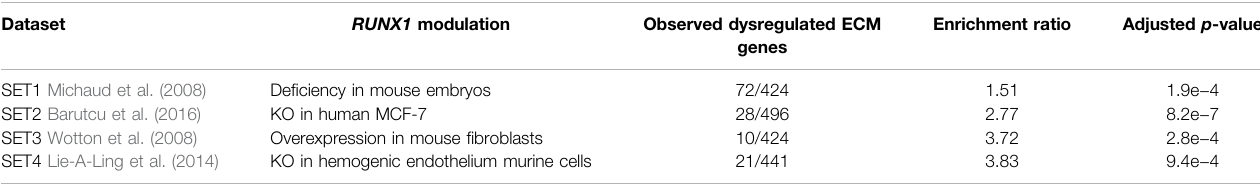
TABLE 2 | Enrichment ratio of “ Extracellular matrix ” GO category for each dataset